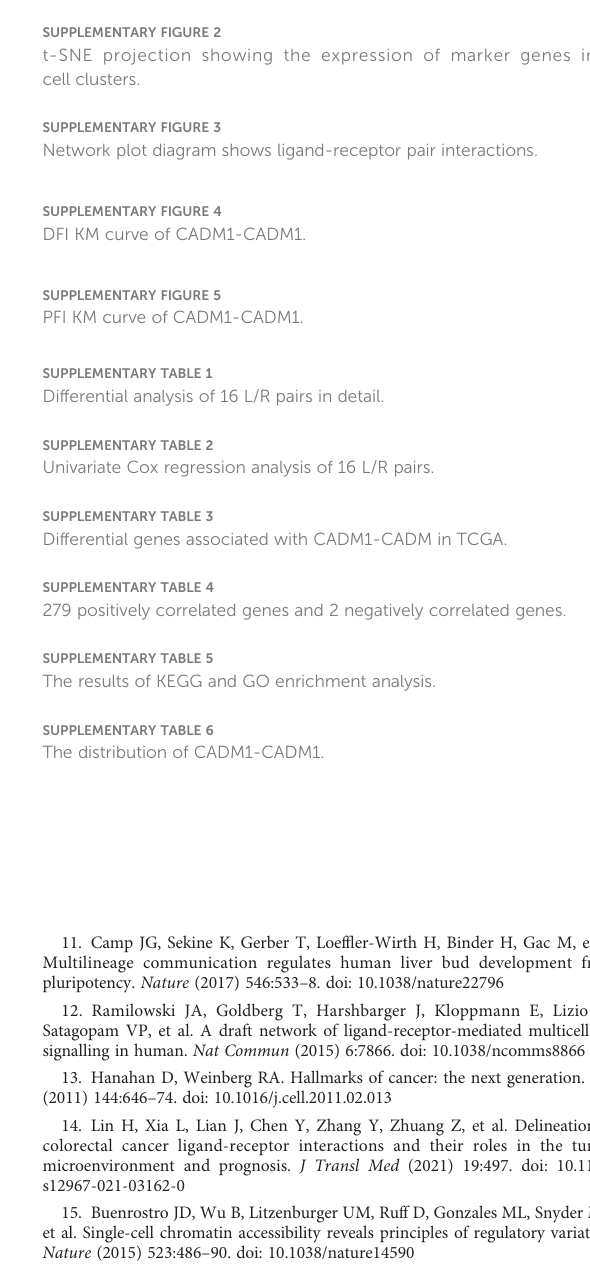
SUPPLEMENTARY FIGURE 4 DFI KM curve of CADM1-CADM1.